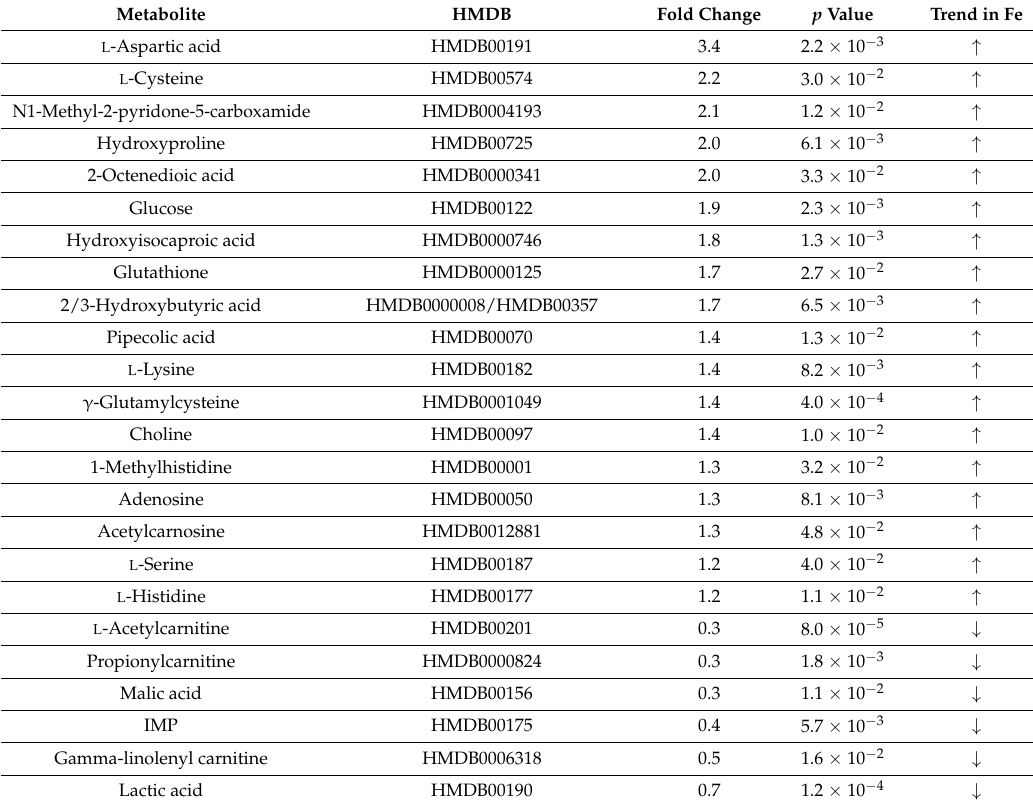
Table 2. Metabolites significantly changing (increasing ↑ , decreasing ↓ ) in plasma after two weeks of a high-iron diet as compared to animals kept on a control diet. Controls (Ctrl, blue, n = 3), high-iron diet (Fe, orange, n = 5). Statistics: Student t -test was performed, fold-change was calculated and a p -value < 0.05 was considered to be